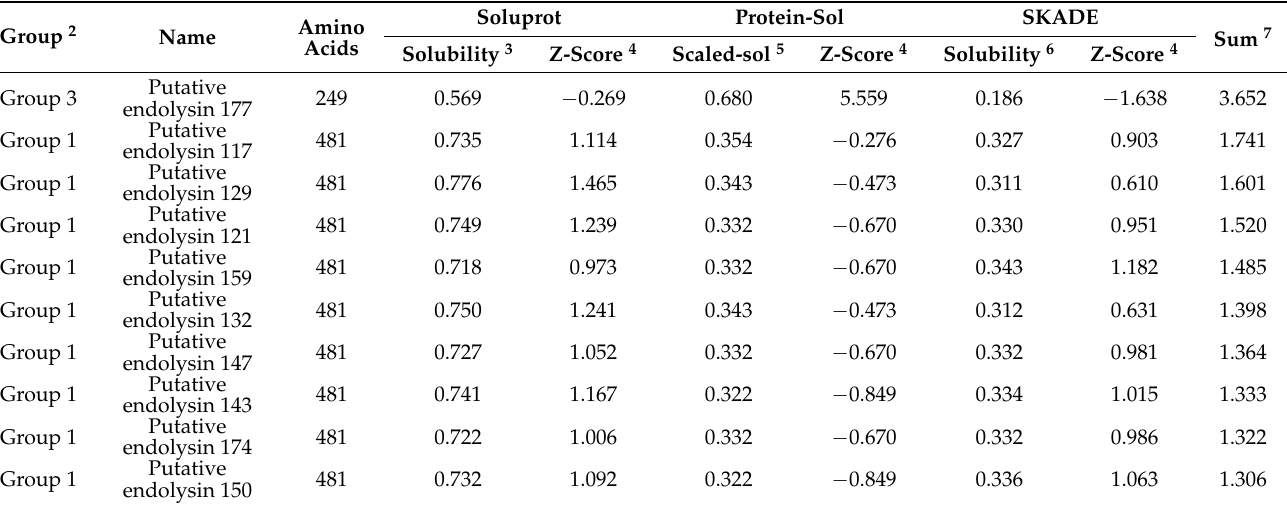
Table 1. Top 10 of predicted recombinant protein solubility of putative endolysins based on Soluprot, Protein-Sol, and SKADE 1